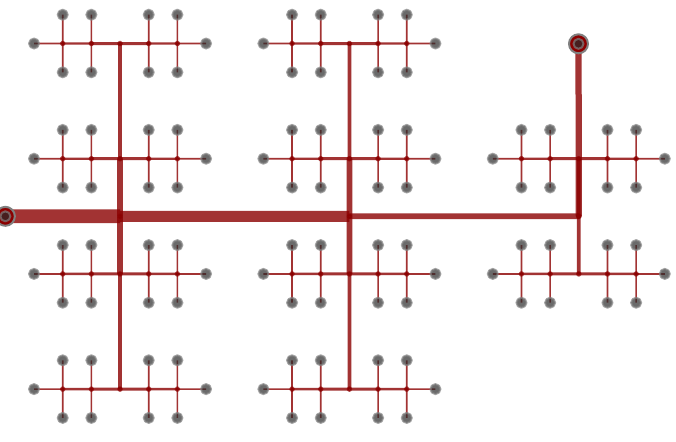
Figure A8. Generic separation scenario